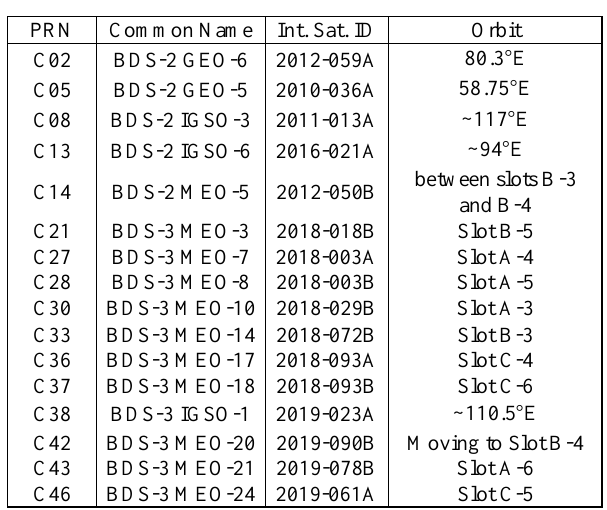
Table 1 . The information of BDS satellites tracked by Huawei mate40 pro. Figure 2 . The sky plot of the observed satellites for one hour.